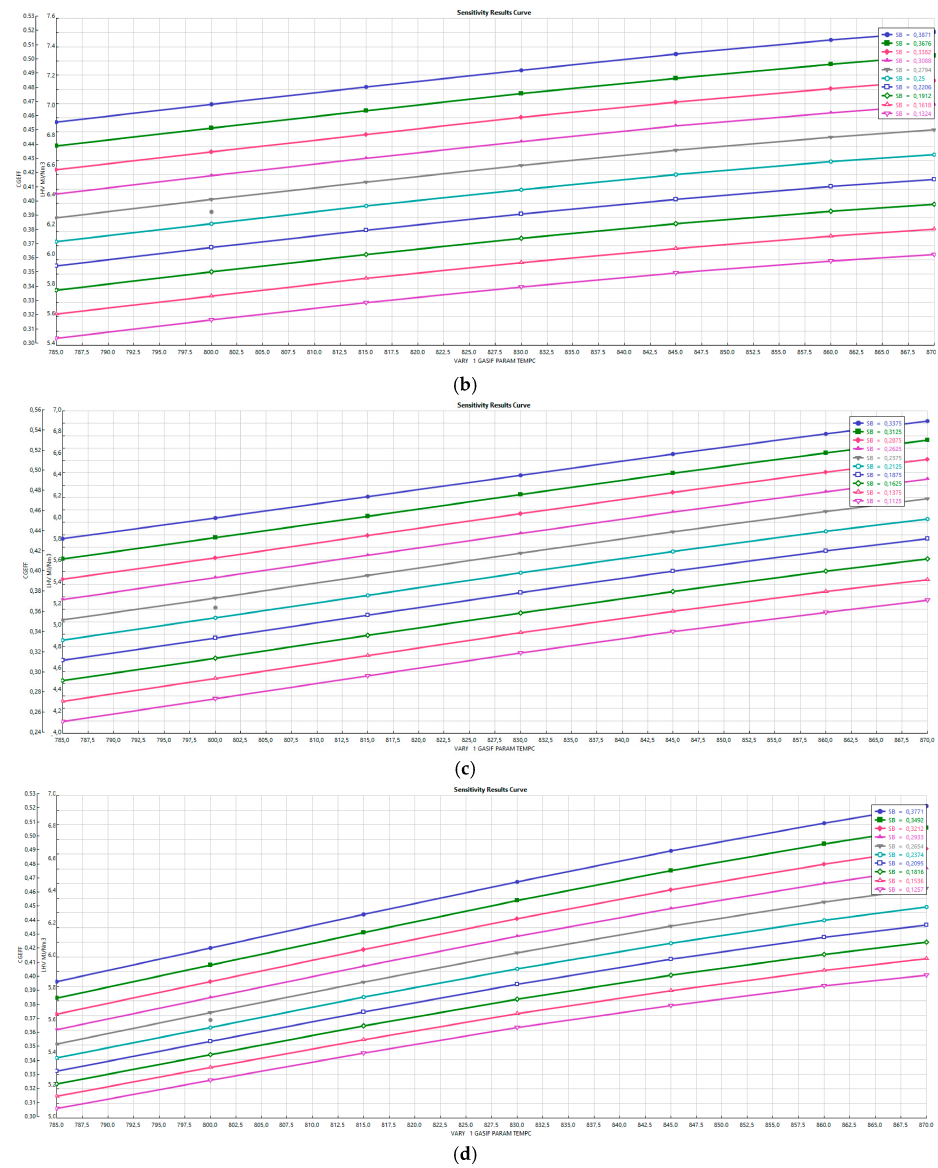
Figure 10. ( a ) Cold gas efficiency and LHV for hazelnut shells. ( b ) Cold gas efficiency and LHV for olive pruning. ( c ) Cold gas efficiency and LHV for olive pomace. ( d ) Cold gas efficiency and LHV for wheat